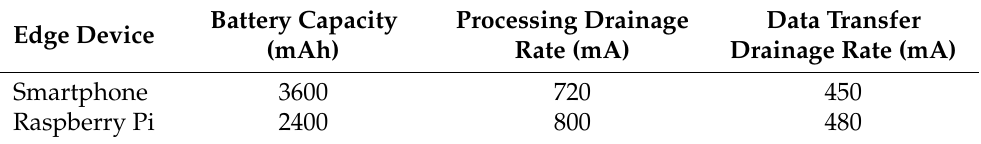
Table 5. Battery consumption rates of edge